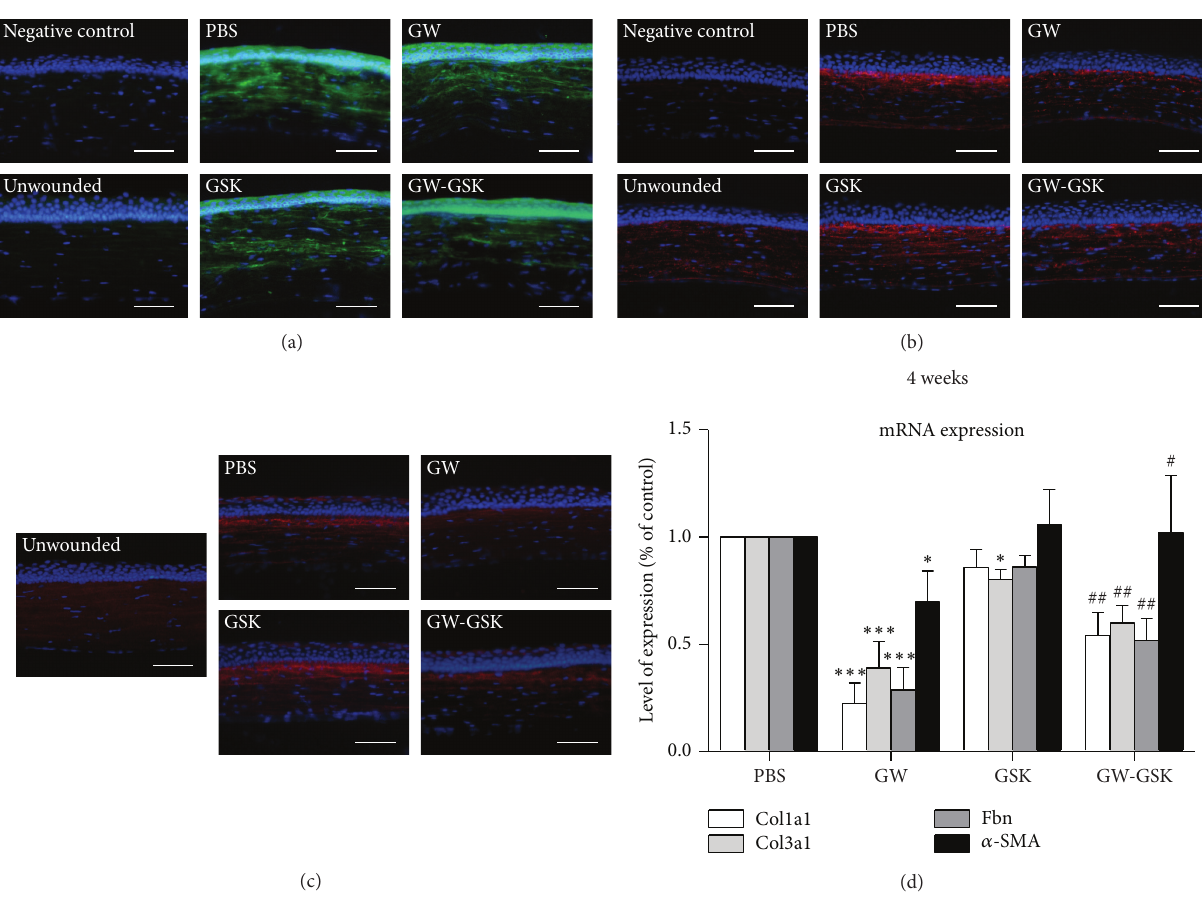
Figure 6: Representative immunofluorescent staining images for 𝛼 -SMA (a) two weeks after laser treatment and fibronectin (b) and collagen type III (c) four weeks after laser treatment. DAPI-stained nuclei are shown in blue, 𝛼 -SMA is shown in green, and fibronectin and collagen type III are shown in red. Scale bars, 50 𝜇 m. (d) mRNA expression of 𝛼 -SMA, fibronectin, collagen type III, and collagen type I at four weeks is depicted in the bar graph. Data are presented as the mean ± SD ( 𝑛 = 3-4), and significant differences were analyzed by ANOVA. ∗ 𝑃 < 0.05 , ∗∗ 𝑃 < 0.01 , ∗∗∗ 𝑃 < 0.001 versus PBS group. # 𝑃 < 0.05 , ## 𝑃 < 0.01 , ### 𝑃 < 0.001 versus GW501516